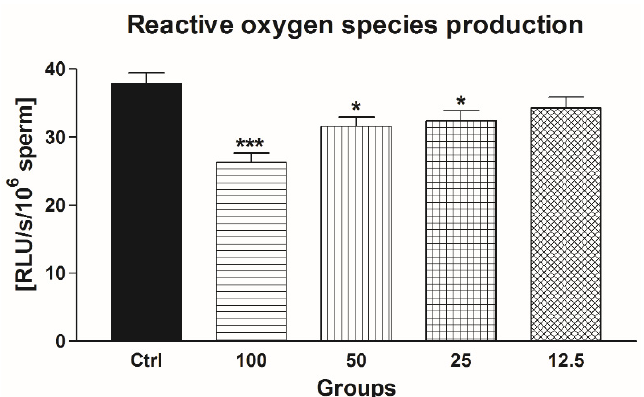
Figure 8. The e ff ect of epicatechin (EPI; µ mol / L) on the ROS production by frozen-thawed bovine Figure 8. The effect of epicatechin (EPI; μ mol/L) on the ROS production by frozen-thawed bovine spermatozoa. * p < 0.05; ** p < 0.01; *** p < spermatozoa. * p < 0.05; ** p < 0.01; *** p < 0.001.